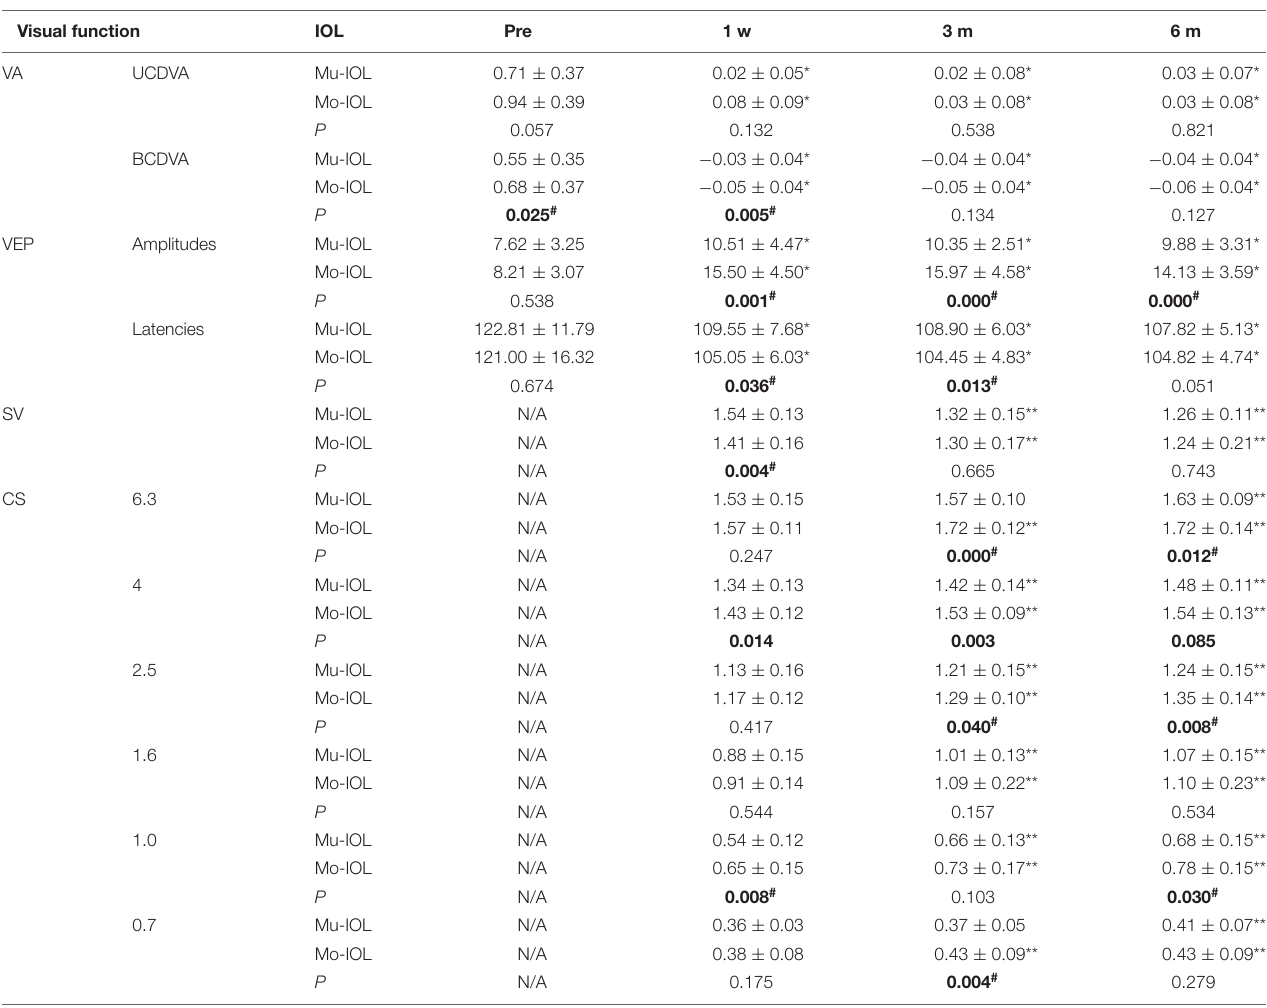
TABLE 1 | Comparison of visual function between the Mu- and Mo-IOL groups. Visual